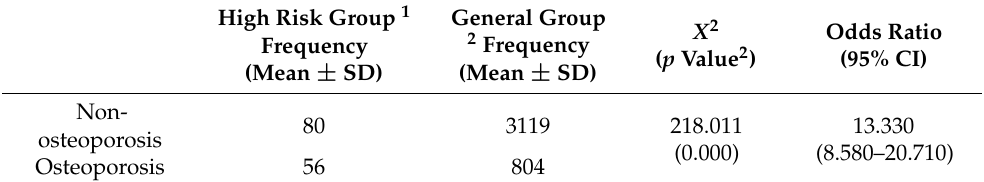
Table 6. Crosstabulation tables of high-risk female subjects 1 for osteoporosis frequency by comor- bid